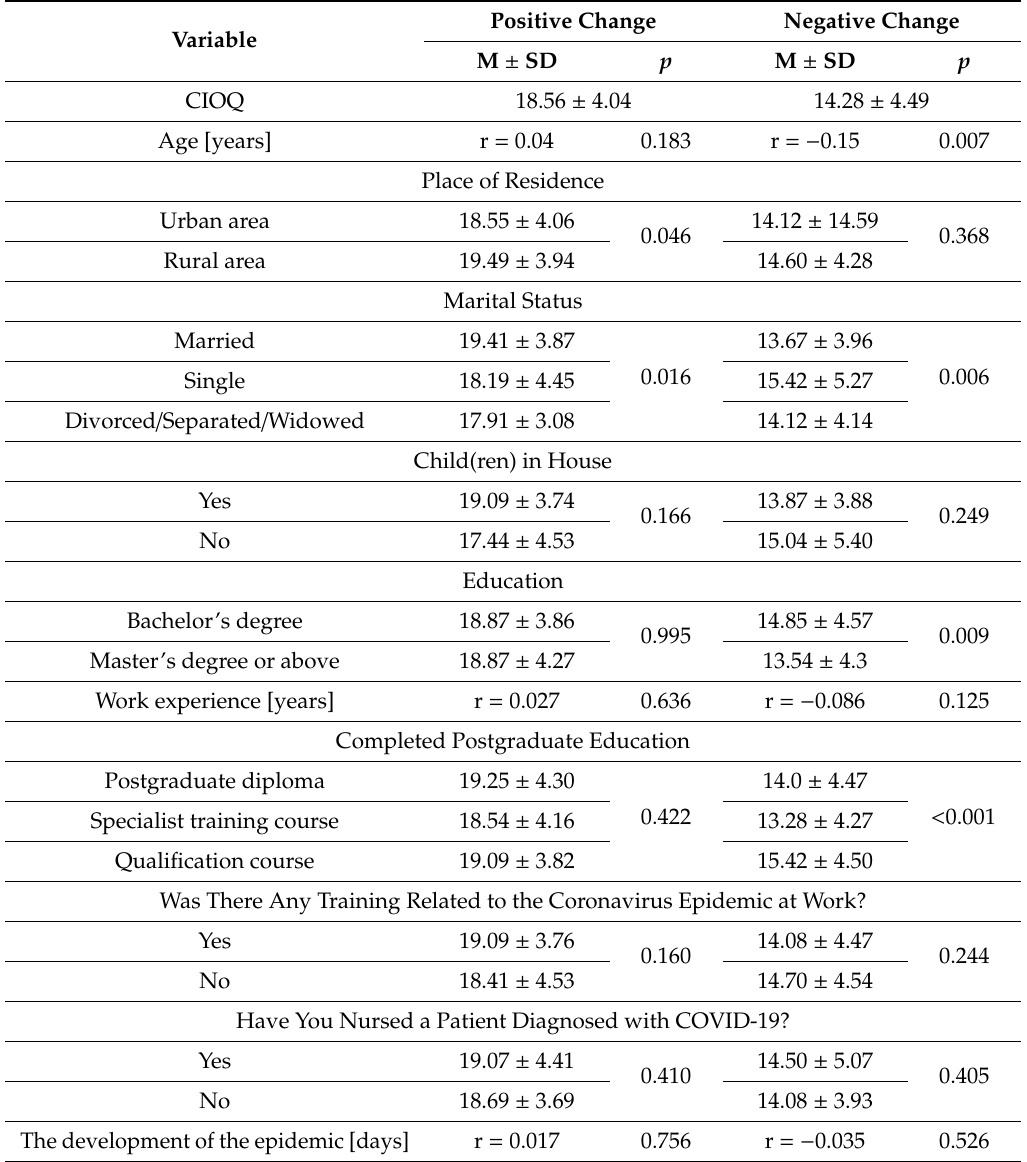
The level of positive and negative consequences of the pandemic and selected sociodemographic